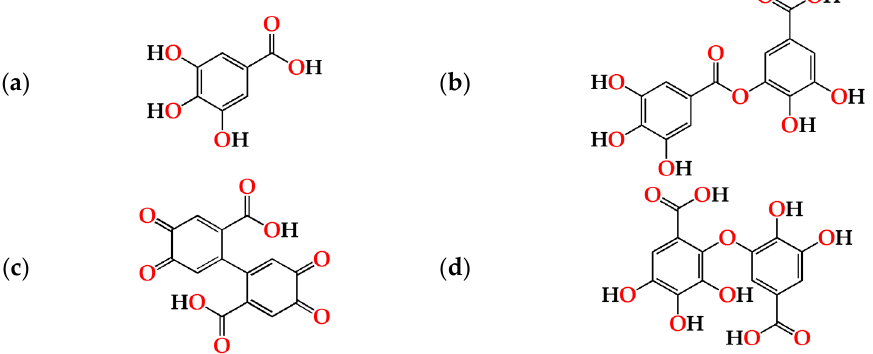
Figure 4. Chemical structures of ( a ) gallic acid, ( b ) digallate (digallic acid) formed by esterification, ( c ) C-C dimer formed by gallic acid autoxidation, ( d ) C-O dimer formed by gallic acid oxidation.